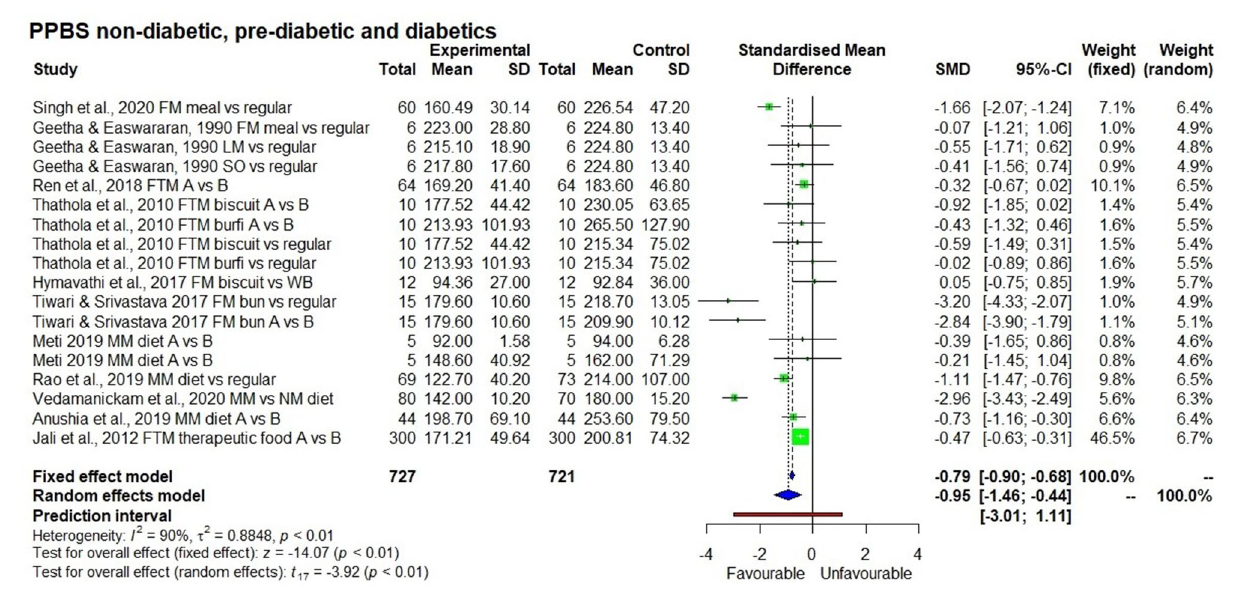
FIGURE 6 | Effect of long term consumption of millet on post-prandial blood glucose levels in non-diabetic, pre-diabetic, and diabetic subjects compared to the control group consuming a regular diet or pre vs post intervention comparison.